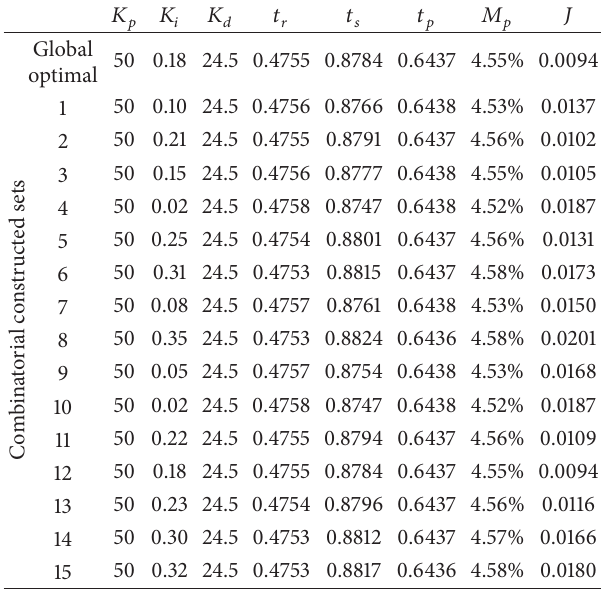
Table 2: Simulation results